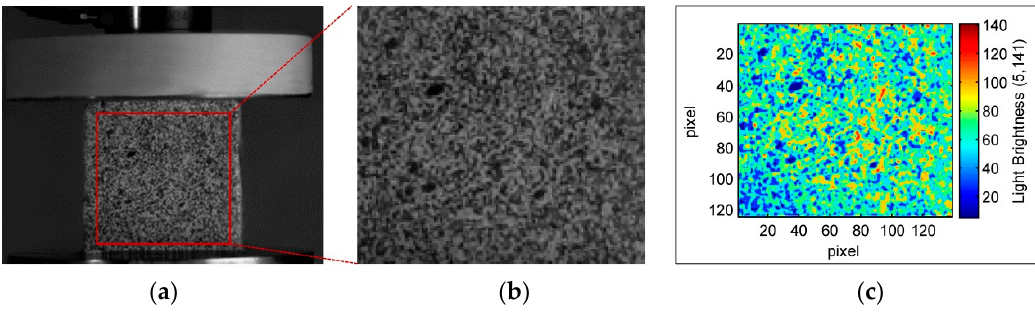
Figure 7. Typical speckle field on the ice specimen surface: ( a ) entire gray-scale image; ( b ) speckle image; and ( c ) pseudo-color image of the speckle field. The speckle size in present experiments is 8–15 pixels.